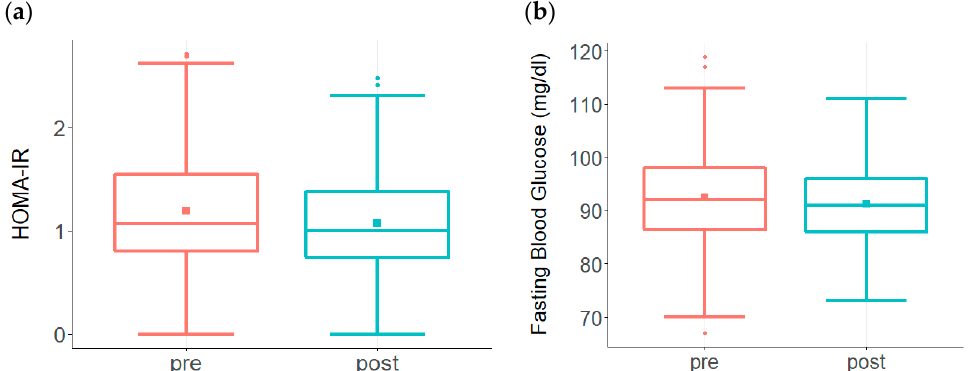
Figure 2. Changes in HOMA-IR and Fasting Glucose levels among participants enrolled in the ReCODE program. ( a ) A significant decline in HOMA-IR ( p < 0.002) was observed in the treatment group ( n = 176) compared to the high levels at baseline. While baseline HOMA-IR ranged from 0 to 2.7 with a mean of 1.2, post-treatment levels ranged from 0 to 2.5 with a mean of 1.07. The baseline median score was 1.1, post-treatment median score was 1.0. ( b ) A significant reduction in fasting glucose ( p < 0.01) is observed among participants ( n = 208) following the treatment protocol. While baseline fasting glucose levels ranged from 67 to 119 with a mean of 93, post-treatment scores ranged from 73 to 111 with a mean of 91. The baseline median score was 92, post-treatment median score was